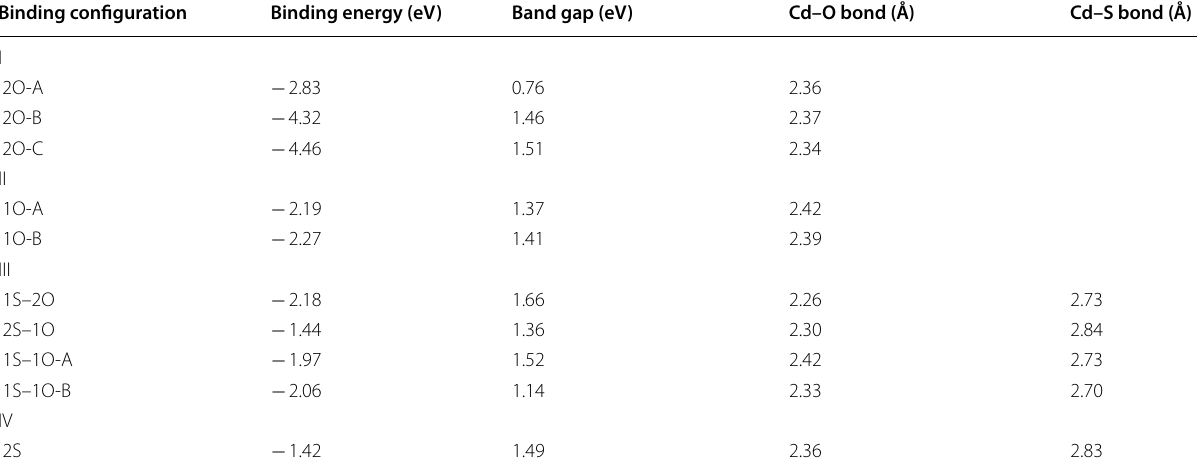
Se composite. The geometries were optimized in vacuum 33 33